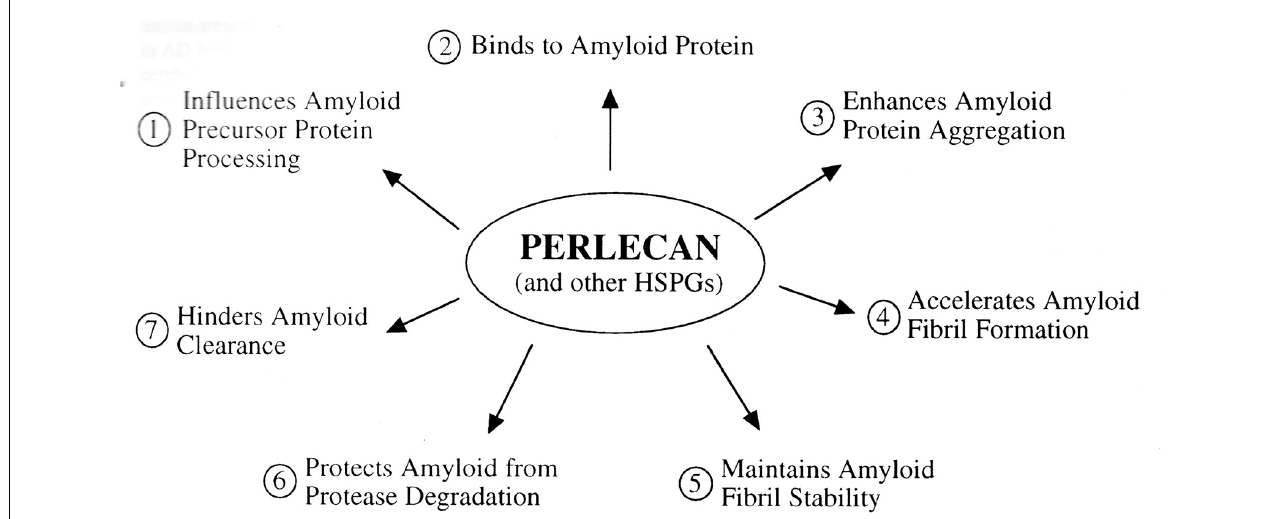
FIGURE 9 | Perlecan and other HSPGs postulated in the pathogenesis of amyloidosis in general, and in AD in particular. The schematic outlines the various effects that perlecan and other HSPGs are postulated to play in the pathogenesis of amyloidosis in general and AD in particular. This was hypothesized by Snow and Wight in 1989. HSPGs were postulated to: (1) influence amyloid precursor protein processing; (2) bind to amyloid proteins; (3) cause an increased aggregation of amyloid proteins; (4) accelerate amyloid fibrils formation; (5) stabilize; (6) protect amyloid from protease degradation; and (7) inhibit amyloid clearance and removal. All of these have now been shown to be true (Snow and Wight, 1989).